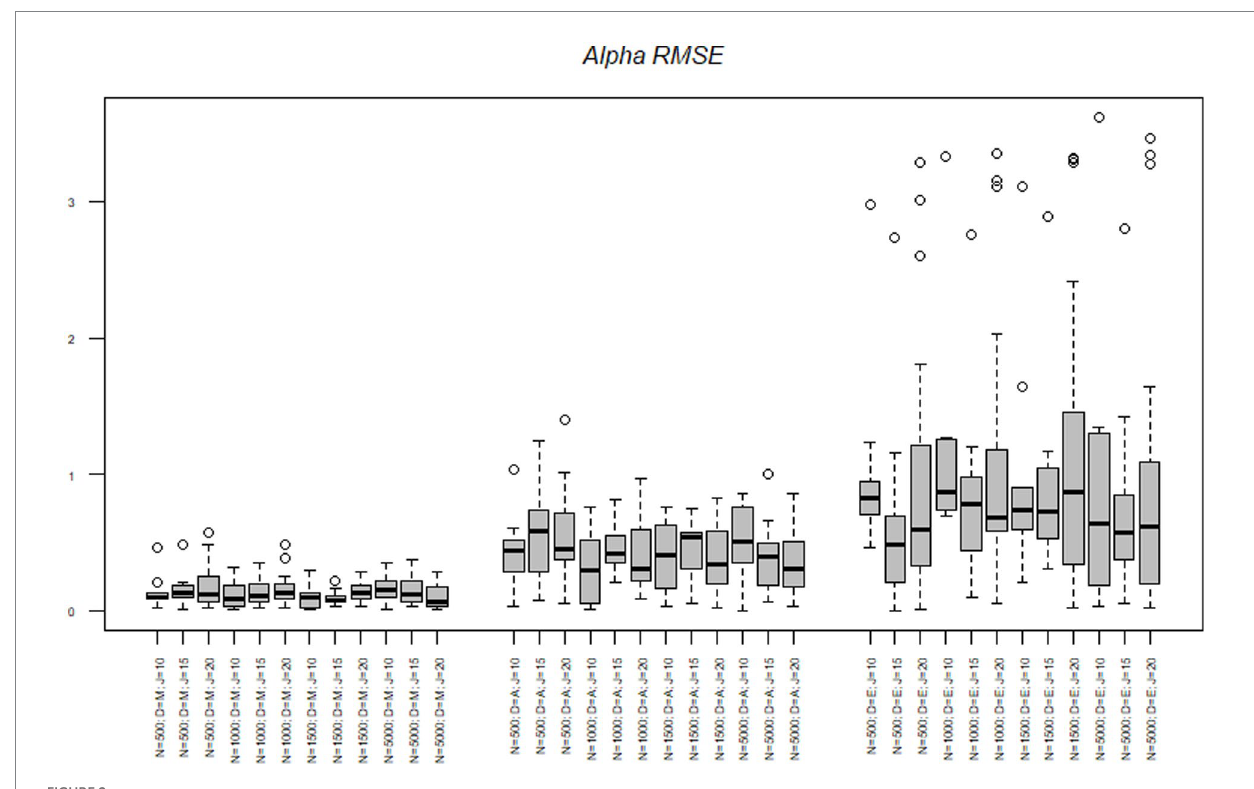
FIGURE 2 Alpha parameter RMSE across nodes, sample size, and test length. N = Sample size; D = Model node; J = Number of items.